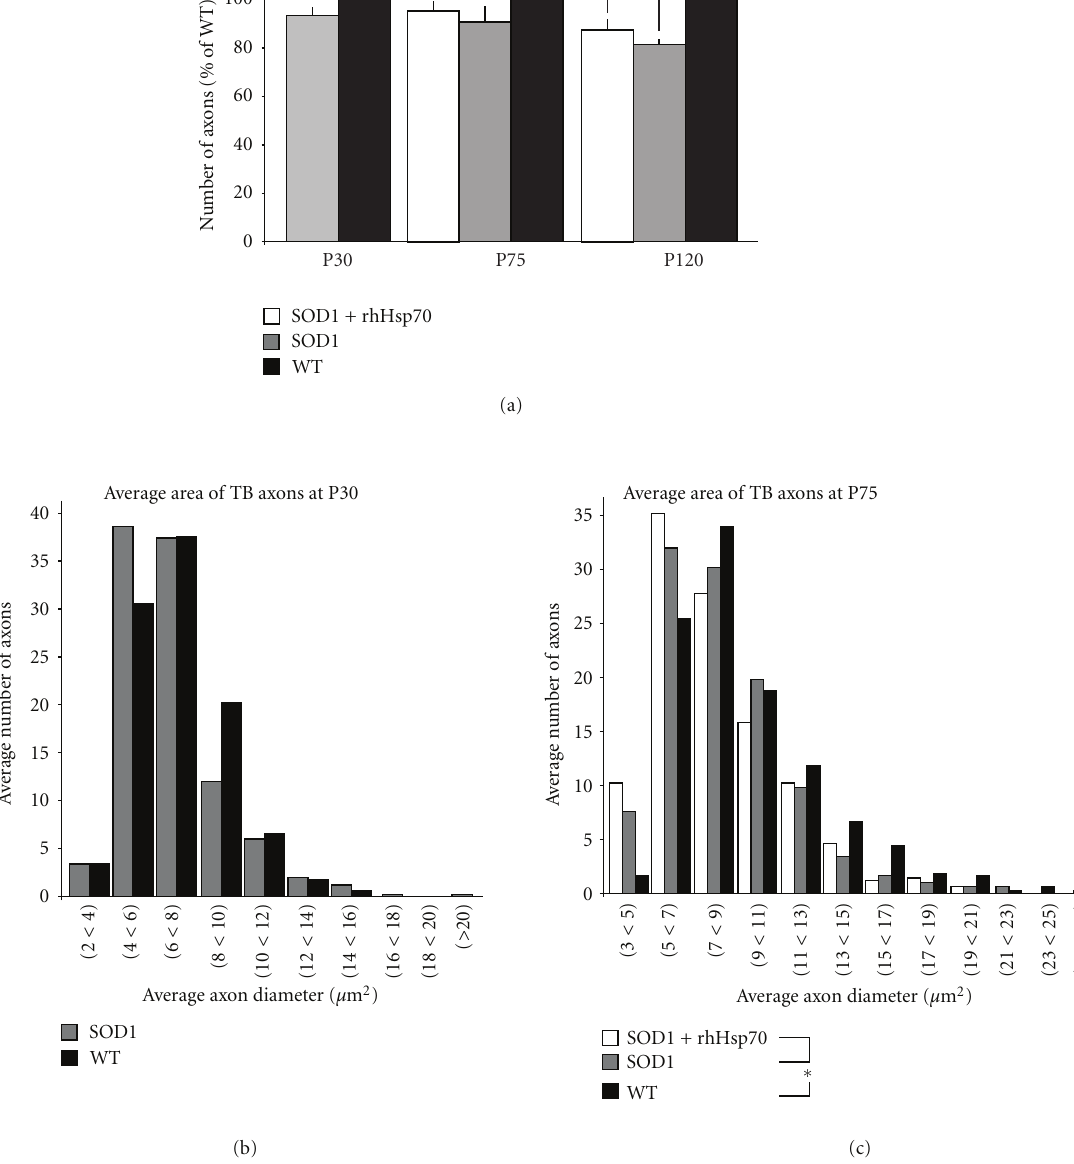
Figure 4: rhHsp70 slows axon atrophy in the tibial branch of the sciatic nerve. (a) There was no di ff erence in the overall number of myelinated axons in the tibial branch of the sciatic nerve at P30 or P75. Data are represented as percent of WT ± SEM at each time point; n = 5 each group. Statistical significance was determined as previously described. (b) Size profiles of the axon area at P30 revealed that there are comparable numbers of larger myelinated axons between WT and SOD1-untreated animals. Axon area and statistical significance were determined as previously described. (c) Axon area analysis determined that only WT animals had a greater number of larger myelinated axons in the tibial branch of the sciatic nerve at P75 ( ∗ P ≤ 0 . 05). Axon area and statistical significance were determined as previously described. Axon area was determined as previously